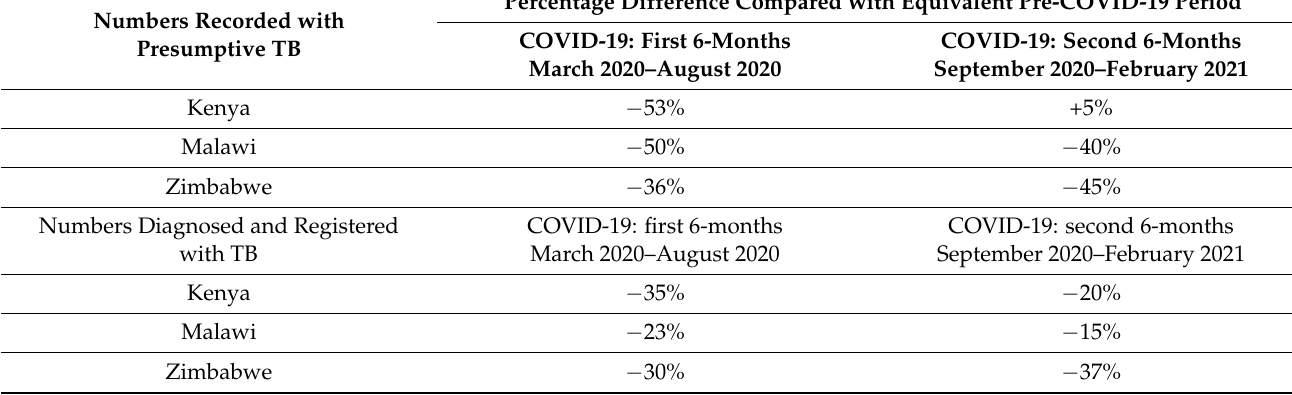
Table 5. Numbers with presumptive PTB and registered TB between first 6-months and second 6-months of COVID-19 in Kenya, Malawi and